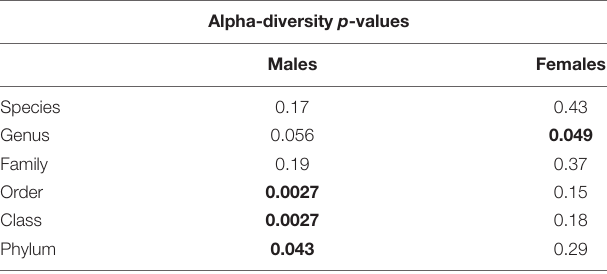
TABLE 1 | Microbiome alpha-diversity was significantly associated with short chain fatty acid (SCFA) supplementation in male mice. Alpha-diversity p -values